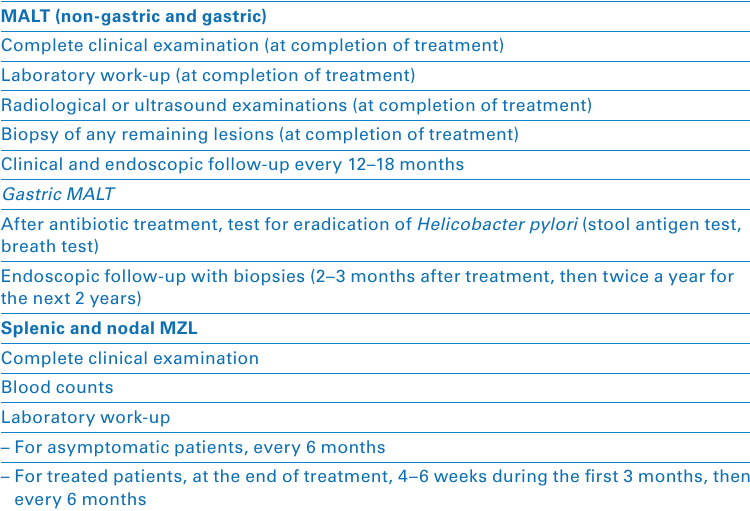
Table 5: Summary of follow-up and monitoring procedures for the marginal zone B-cell lymphoma (MZL) entities [57]. MALT (non-gastric and gastric) Complete clinical examination (at completion of treatment) Laboratory work-up (at completion of treatment) Radiological or ultrasound examinations (at completion of treatment) Biopsy of any remaining lesions (at completion of treatment) Clinical and endoscopic follow-up every 12–18 months Gastric